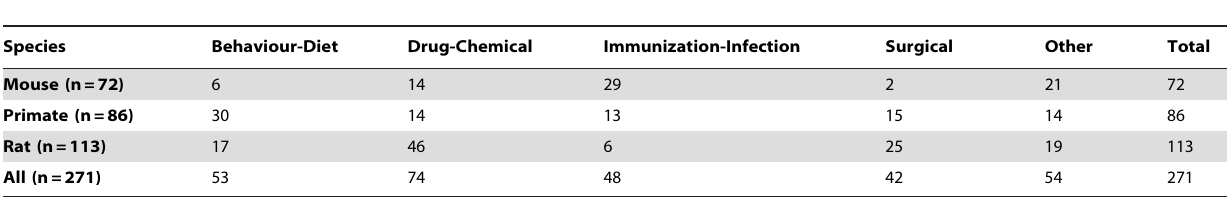
Table 1. Number of papers classified into general type of treatment procedure described in the study.